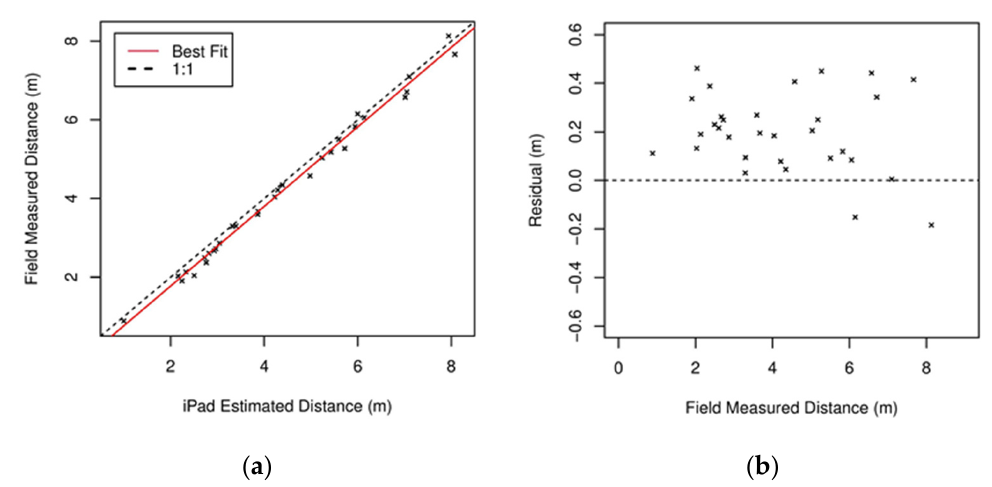
Figure 19. Distance comparison between iPad LiDAR and a conventional measurement method (laser distance meter) in an urban forest: ( a ) regression plots for the distance between trees measured using iPad LiDAR and laser distance meter, and ( b ) residuals for the estimated field measured distance.